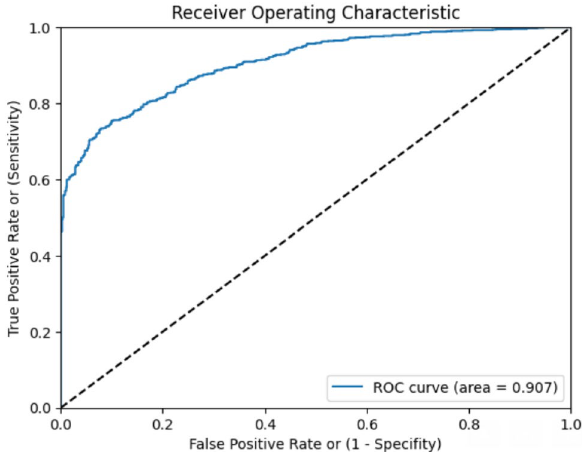
Figure 6. The provided ROC curve illustrates the performance of a TB prediction model constructed using pilot